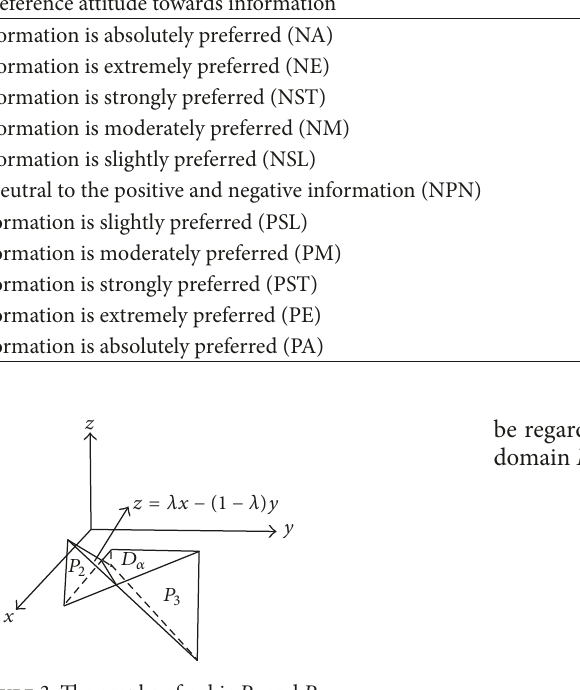
Figure 3: The graphs of cubic 𝑃 2 and 𝑃 3